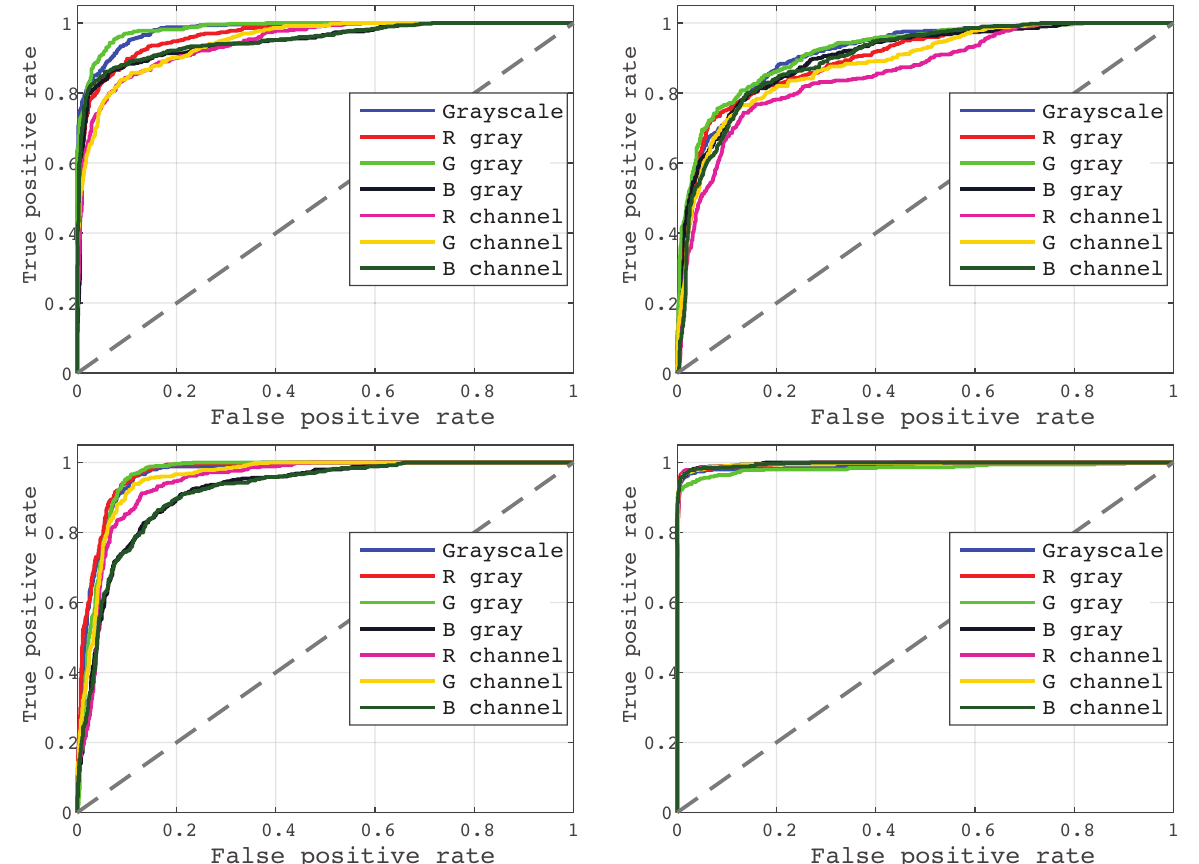
Figure 5. ROC curves generated by all models on the testing set for: (upper row, from left to right) normal ear, chronic otitis media; (lower row, from left to right) otitis media with effusion, and earwax plug.